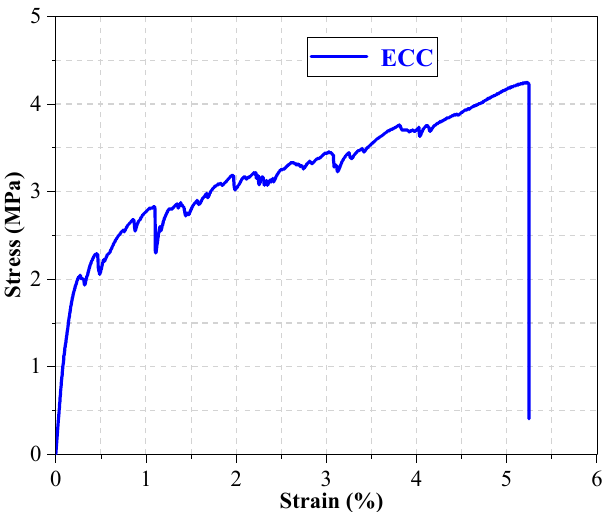
Figure 3. The cracking diagram of ECC.